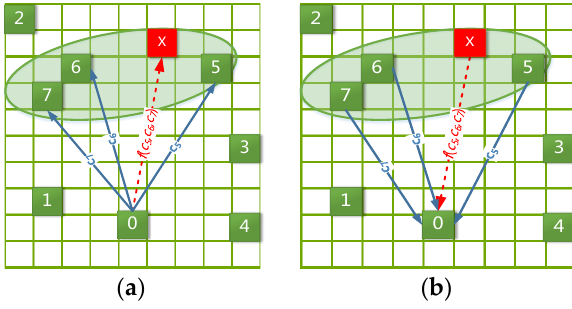
Figure 4. ( a ) trajectory location to peripheral location ( b ) peripheral location to trajectory location.